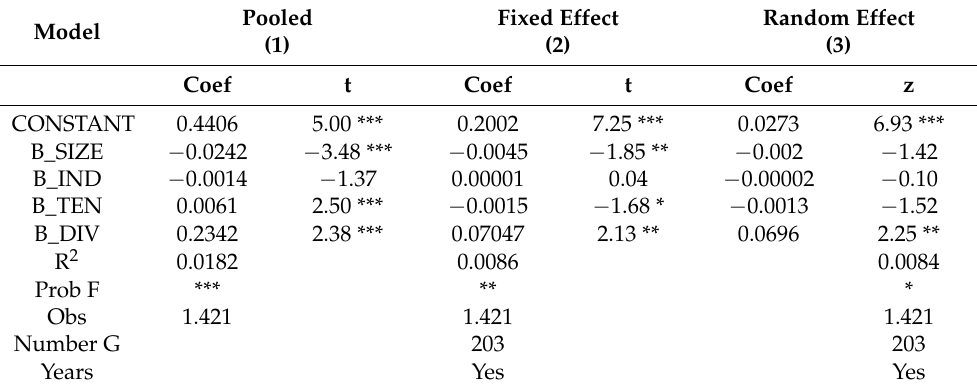
Table 4. Multivariate